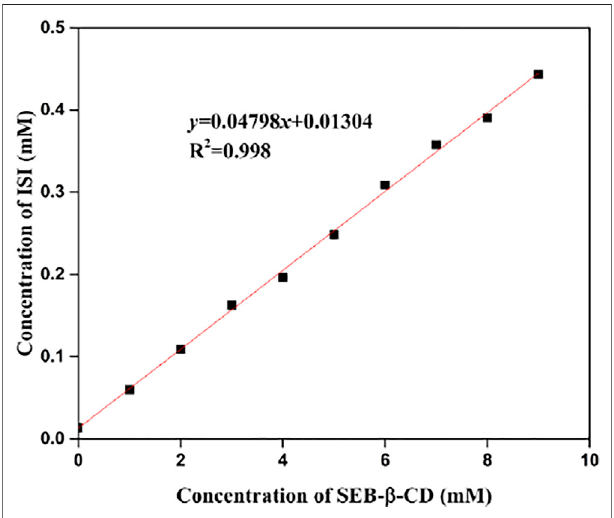
FIGURE 5 | A phase solubility diagram of the ISL-SBE- β -CD system.